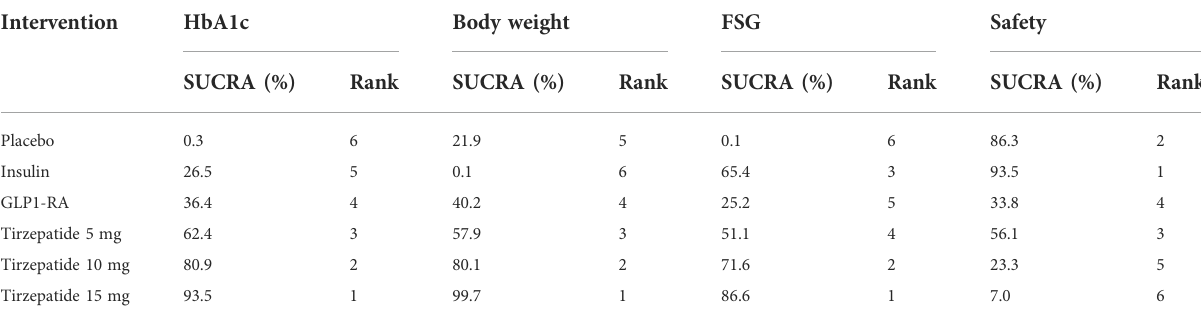
TABLE 2 Ranking probability of various